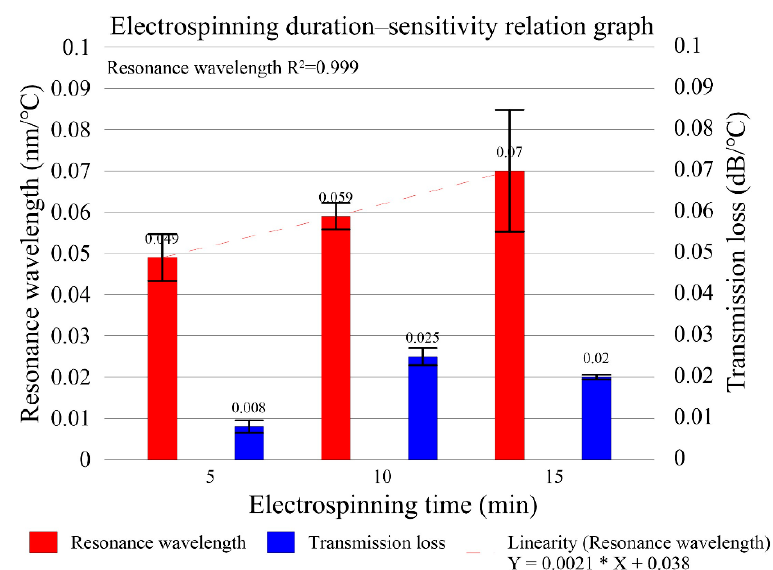
Figure 9. Spectrum generated at an electrospinning duration of ( a ) 5 min; ( b ) 10 min; and ( c ) 15 min; spectrum analysis with the error bars at an electrospinning duration of ( d ) 5 min; ( e ) 10 min; and ( f ) 15 min.